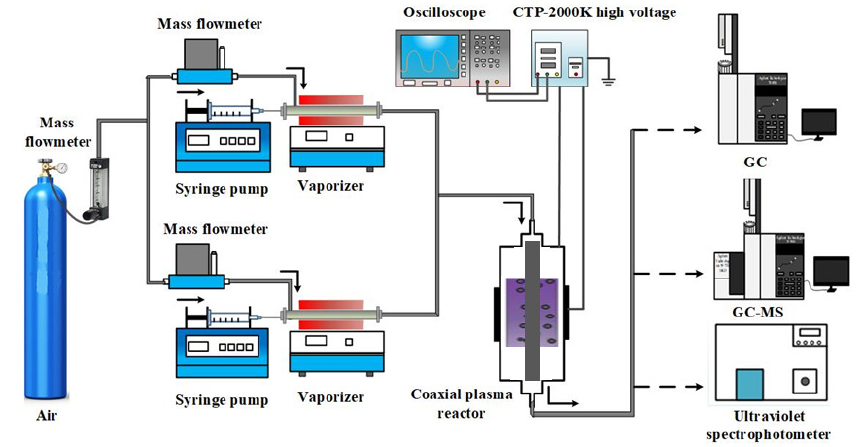
Figure 10. Schematic diagram of the experimental system.